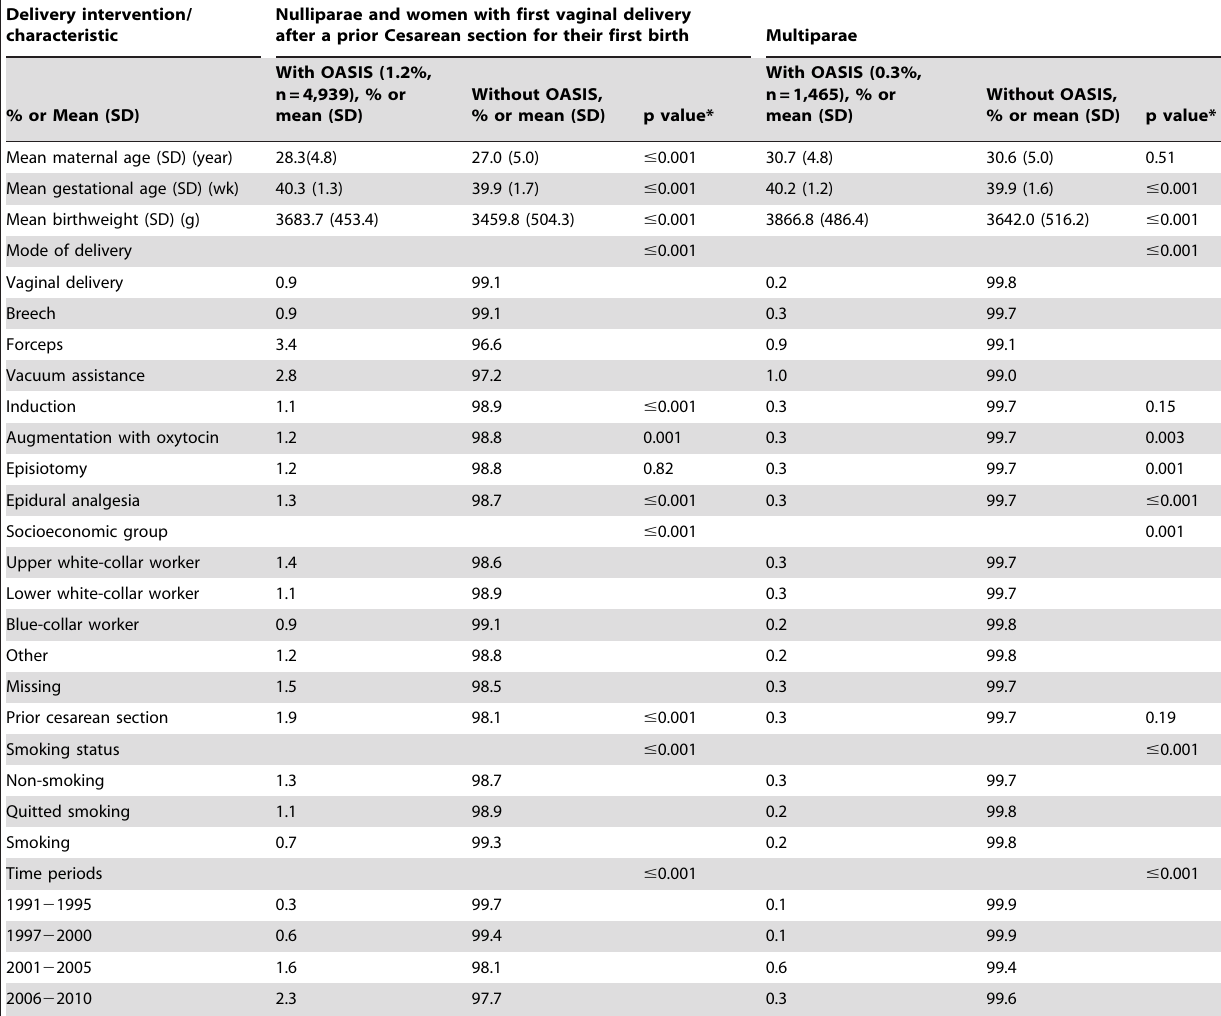
Delivery intervention/